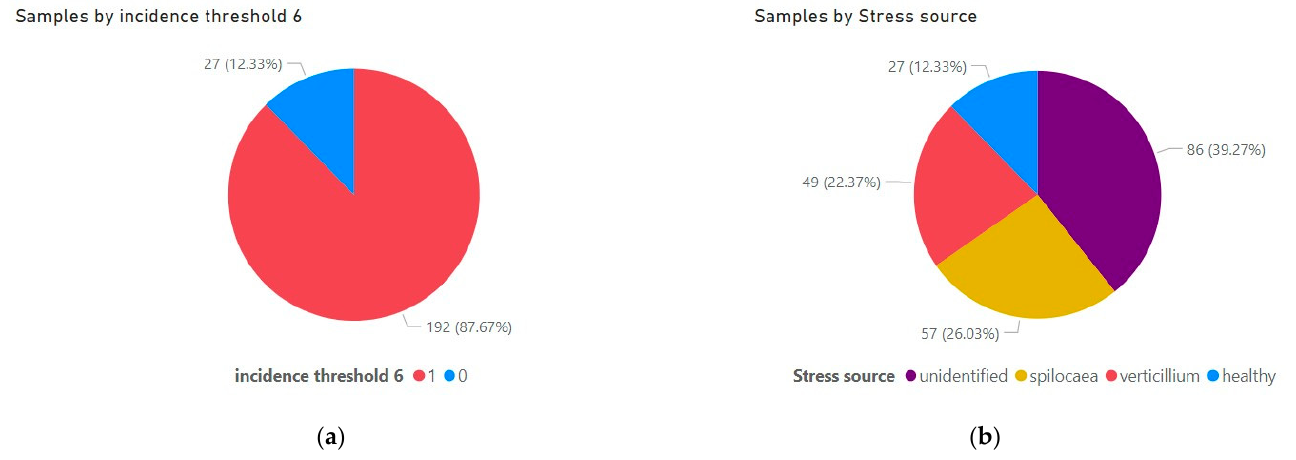
Figure 10. ( a ) Stress incidence class size when setting a threshold of 6 on the dataset. ( b ) Stress source class size on the dataset when setting a threshold of 6 for stress incidence. Class sizes were resampled using SMOTE.